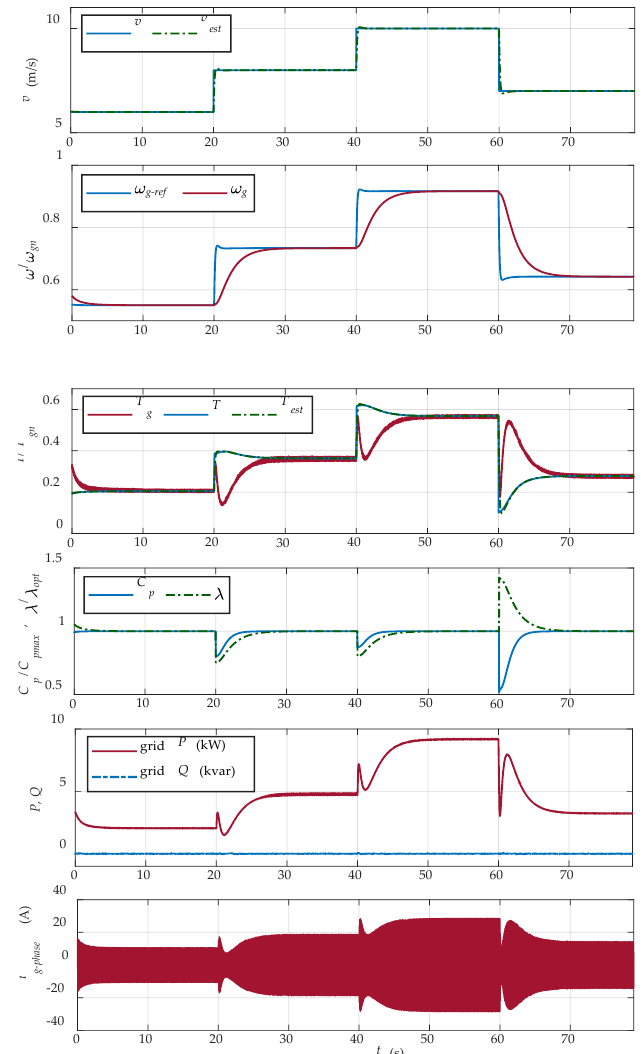
Figure 10. Plots of the WECS variables for theoretical step-change wind speed profile 6 → 8 → 10 → 7 m / s. P and Q denote mean active and reactive power at the grid side of the RL filter (see Figure 1), T gn = 1910 Nm and i g_phase shows the envelope of the PMSG variable-frequency phase current. The operation of the WECS for a more realistic wind speed profile with a slowly varying sine component and rapid random gusts is presented in Figure 11.